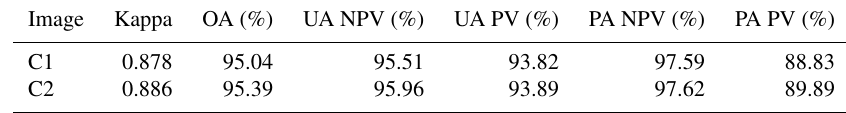
Table 3. Validation parameters for the model trained model with different variables